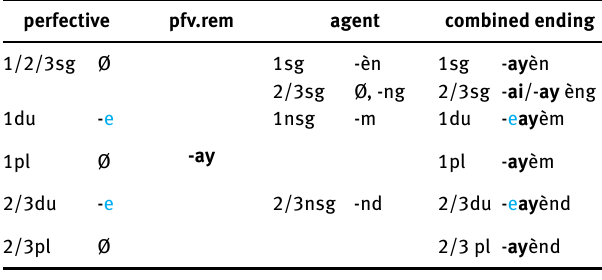
Table 9: Perfective remote punctual